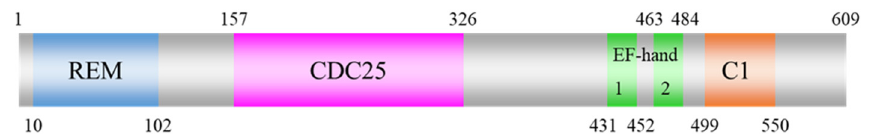
Figure 1. Domain architecture of RASGRP2. RASGRP2 is a multidomain protein consisting of a REM region, a CDC25 domain, two EF hands, and a C1 domain. GenomeNet server (https://www.genome.jp/tools/motif/, accessed on 14 October 2021) was used to search for specific motifs in protein sequences.